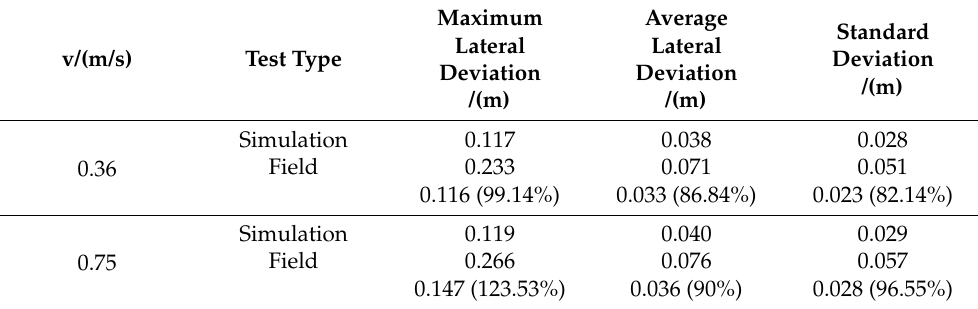
Table 10. Comparison of simulation and field experiment path-tracking